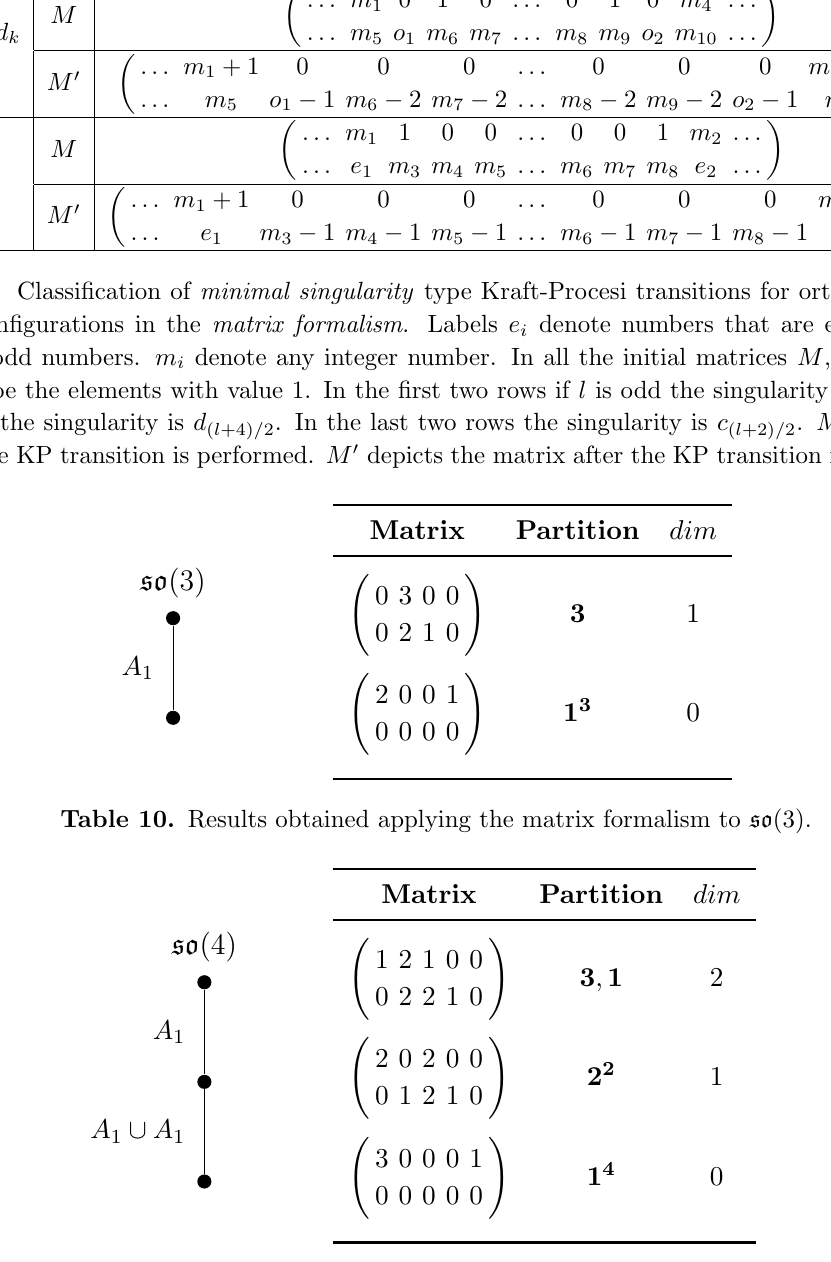
Table 11. Results obtained applying the matrix formalism to so (4). the matrix does not have a brane system counterpart. dim denotes the quaternionic di- mension of each orbit. In the matrix formalism this can be obtained